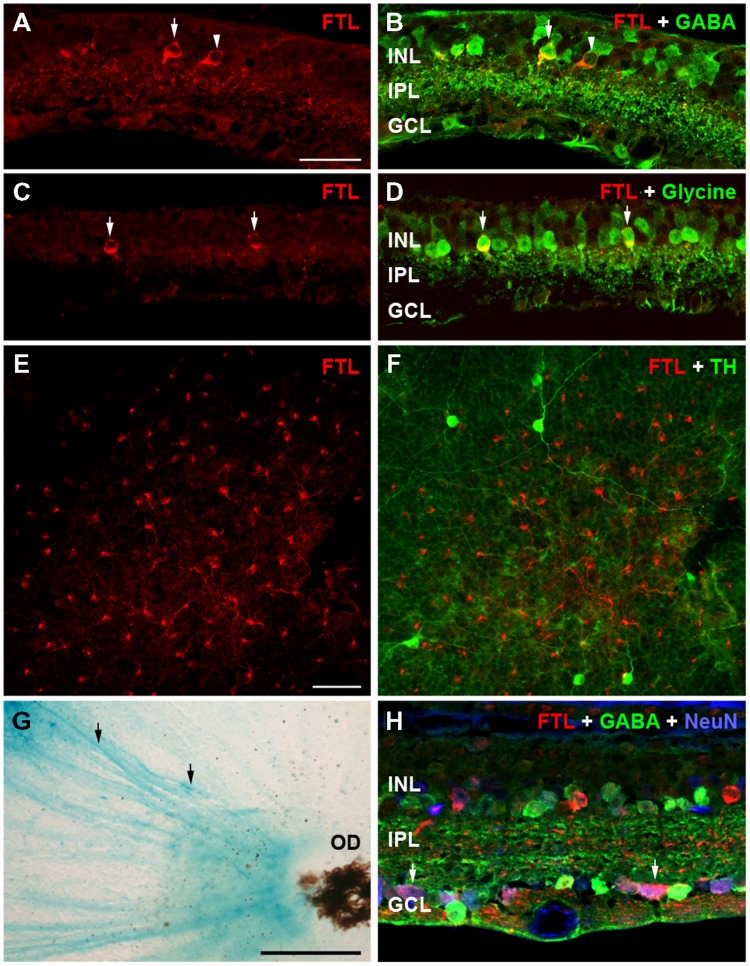
Amacrine and ganglion cells express the FTL reporter within the inner retina of rd1-FTL. Retinal sections of rd1-FTL mouse (6 months of age) were labeled with anti-β-galactosidase (A,C,E; red), which identifies FTL reporter expression (see white arrows in A,C). Retinal sections were co-labeled with GABA (B), or glycine (D) showing FTL was co-localized within subpopulations of GABA immunoreactive (B, white arrows) and glycine immunoreactive (D, white arrows) amacrine cells. Retinal wholemounts were double labeled with anti-β-galactosidase and tyrosine hydroxylase (E,F; respectively) and no co-localization was evident. Rd1-FTL wholemount from a 4.5 month-old animal was also labeled using β-galactosidase histochemistry showing ganglion cell axons projecting to the optic nerve express the reporter (G, black arrows). This ganglion cell expression was confirmed in vertical sections of rd1-FTL retina, which were triple labeled for β-galactosidase (red), GABA (green) and NeuN (Blue). There are numerous cells in the GCL that are co-labeled with FTL and NeuN (H, white arrows). Abbreviations: INL, inner nuclear layer; IPL, inner plexiform layer; GCL, ganglion cell layer, OD, optic disk. Scale bar for (A–F,H): 50 μm; (G): 250 μm.